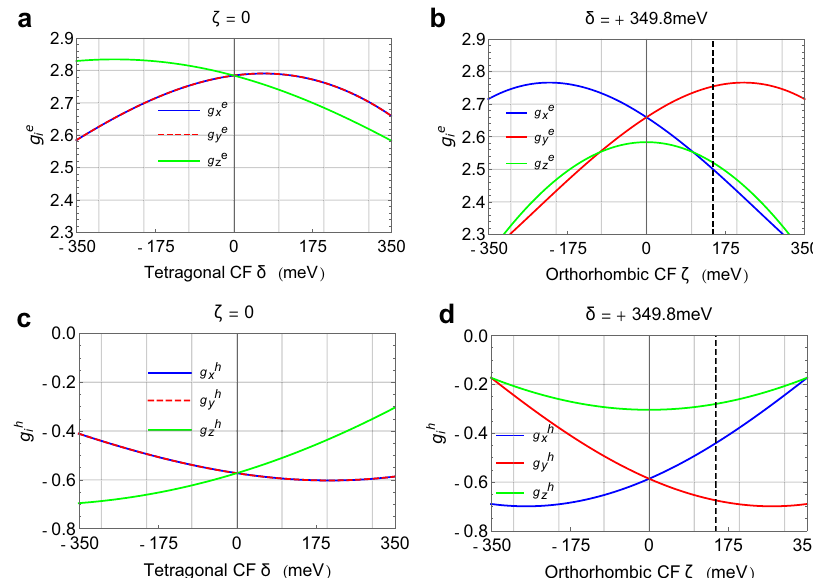
Fig. 5 Calculated electron and hole g-factors in MAPbI 3 . a and c The calculated electron and hole g-factors in tetragonal MAPbI 3 as a function of the tetragonal crystal fi eld (CF), δ , with orthorhombic CF ζ ¼ 0. b and d The electron and hole g-factors in orthorhombic MAPbI 3 for fi xed tetragonal CF δ = + 349.8meV, determined by fi t to the measured g-factors, as a function of the orthorhombic CF, ζ . The best- fi t value for ζ is + 147.7 meV, marked in panels ( b , d ) with a vertical dashed black line. The subscripts x , y and z on the g-factor components denote the [1,0,0], [0,1,0] and [0,0,1] crystallographic directions. In the calculations shown, the bandgap E g , the SOC split-off parameter Δ , the Kane energy E p , and Luttinger ’ s magnetic parameter κ have the values shown in Table 1. From the values plotted, the g-factors along the ½ 1 (cid:1) 10 (cid:2) direction are obtained as 29 g e ½